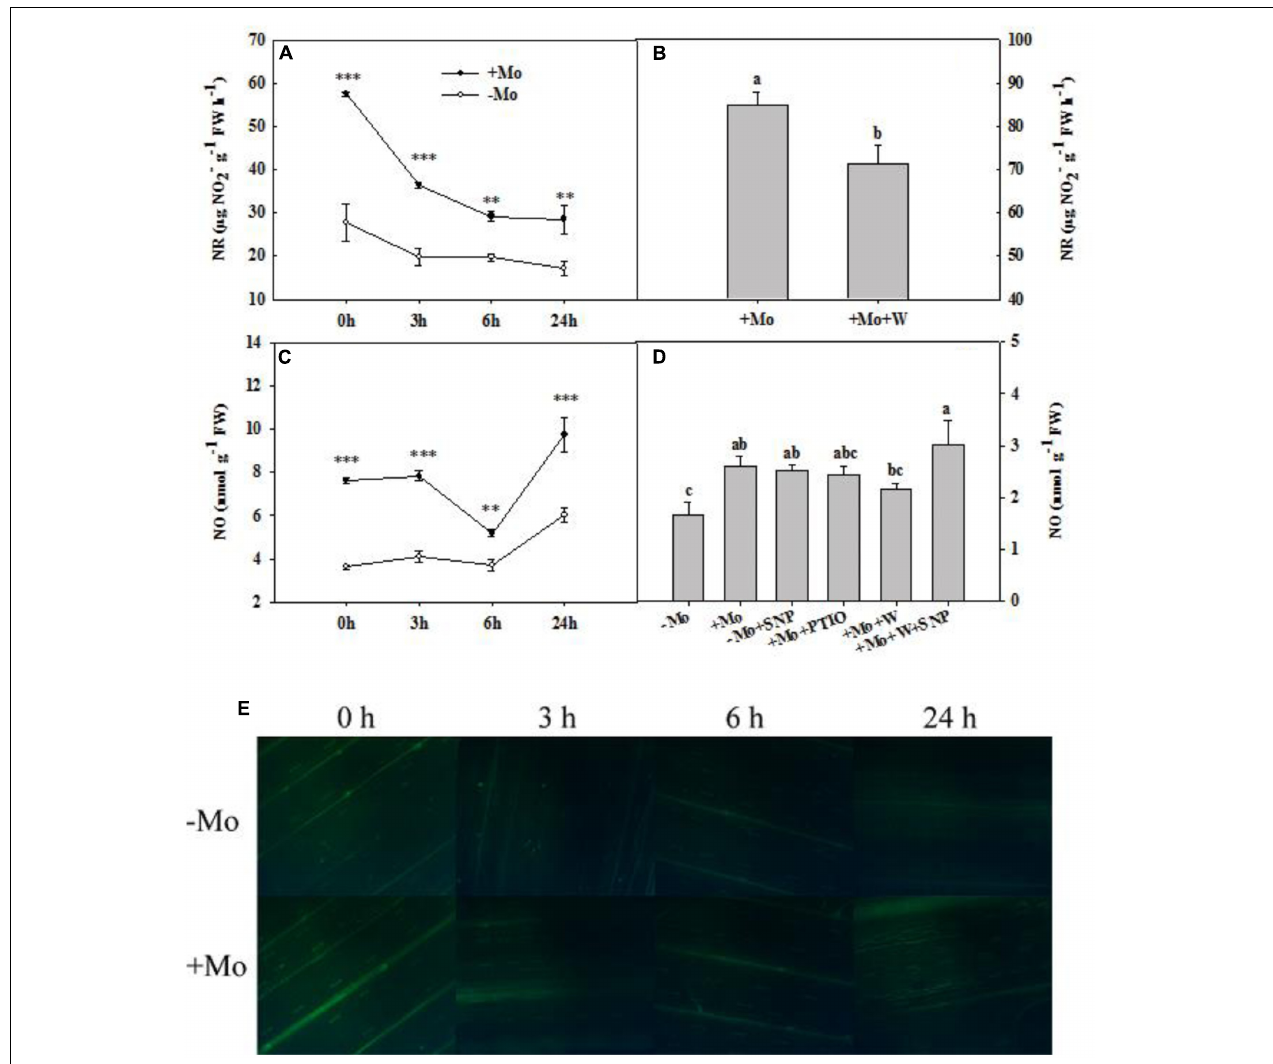
FIGURE 4 | Nitrate reductase (NR) activity and nitric oxide (NO) content. Effects of molybdenum (Mo) application on NR activity (A) and NO production (C,E) in wheat leaves under polyethylene glycol 6000-simulated drought stress (PSD). –Mo and +Mo treatments represent wheat grown in modified Hoagland solution with 0 and 1 µ M Mo, respectively. 0, 3, 6, and 24 h represent 0, 3, 6, and 24 h of polyethylene glycol 6000 (PEG) stress, respectively. Bar = 100 µ m. Asterisk ( ∗ ) indicates significant difference between –Mo and +Mo treatments by ANOVA followed by Duncan-test multiple comparisons ( ∗∗ P < 0.01, ∗∗∗ P < 0.001, n = 4). (B) Effects of 100 µ M tungsten (W, Mo-enzymes inhibitors) on NR activity in wheat leaves. The 30-day-old seedlings grown in +Mo Hoagland solutions were detached and placed in distilled water for 2 h to eliminate potential wound stress and firstly pretreated with/without 100 µ M W for 4 h, and then exposed to 10% polyethylene glycol 6000 (PEG) for 6 h. (D) Effects of Mo, 100 µ M W, 200 µ M 2-phenyl-4,4,5,5-tetramethylimidazoline-3-oxide-1-oxyl (PTIO, NO scavenger) and 100 µ M sodium nitroprusside (SNP, NO donor) on NO production in wheat leaves. The 30-day-old seedlings grown in –Mo and +Mo Hoagland solutions were detached and placed in distilled water for 2 h to eliminate potential wound stress and firstly pretreated with/without 200 µ M PTIO or 100 µ M W for 4 h, and then exposed to 10% polyethylene glycol 6000 (PEG) with/without 100 µ M SNP for 6 h. Seedlings cultivated with –Mo and +Mo solutions were regarded as the control. Different letters indicate significant differences between treatments by the Duncan-test ( p < 0.05, n =